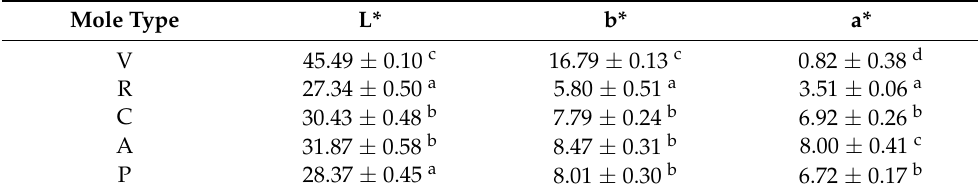
Table 2. Values of L*, a*, and b* color five varieties of mole from the State of Hidalgo. Mole Type